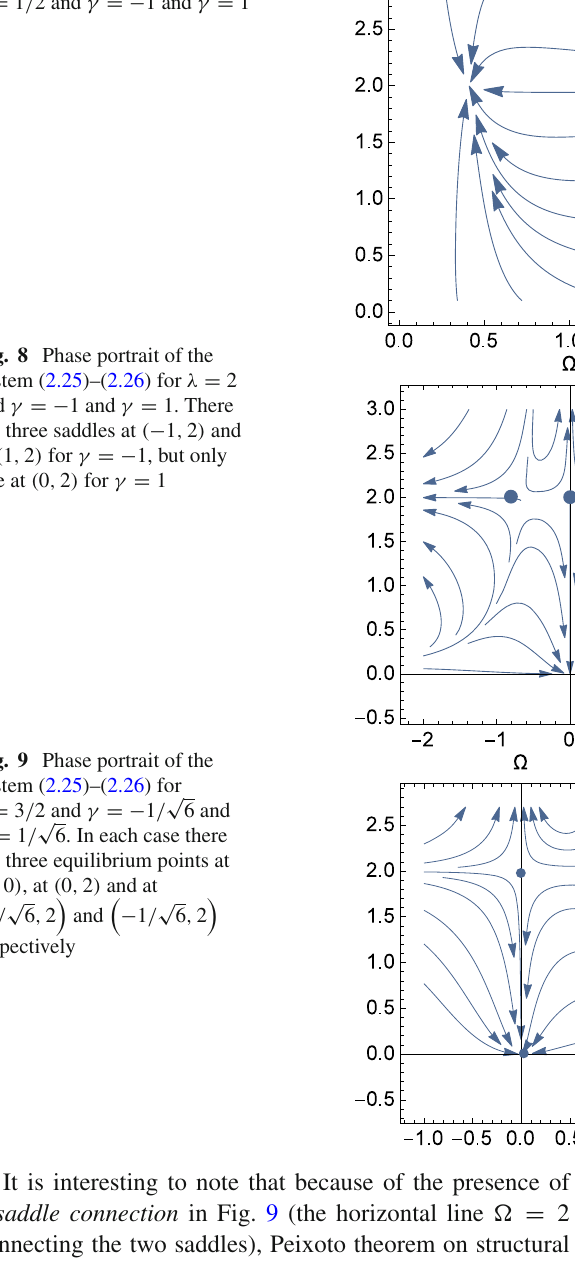
Fig. 8 Phase portrait of the system (2.25)–(2.26) for λ = 2 and γ = − 1 and γ = 1. There are three saddles at ( − 1 , 2 ) and at ( 1 , 2 ) for γ = − 1, but only